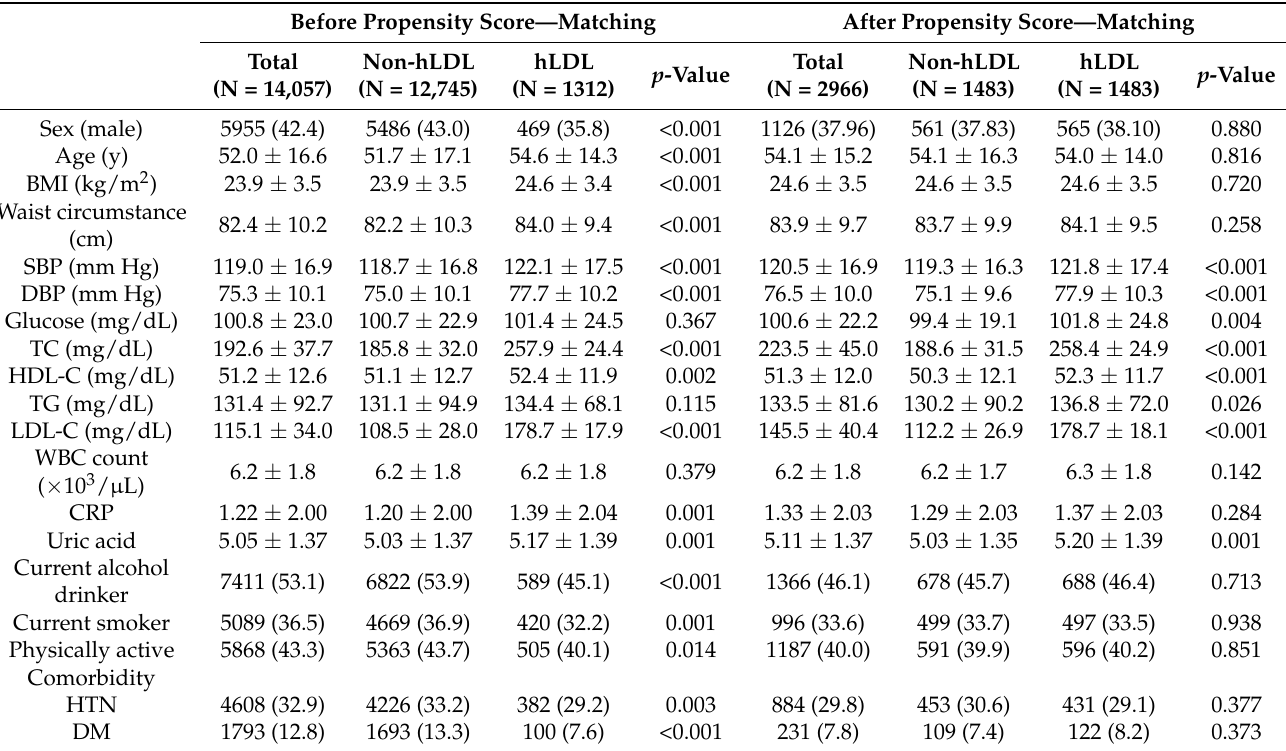
Table 1. Clinical characteristics of study population according to the presence of hyper-low-density lipoprotein cholesterolemia. Before Propensity Score—Matching After Propensity